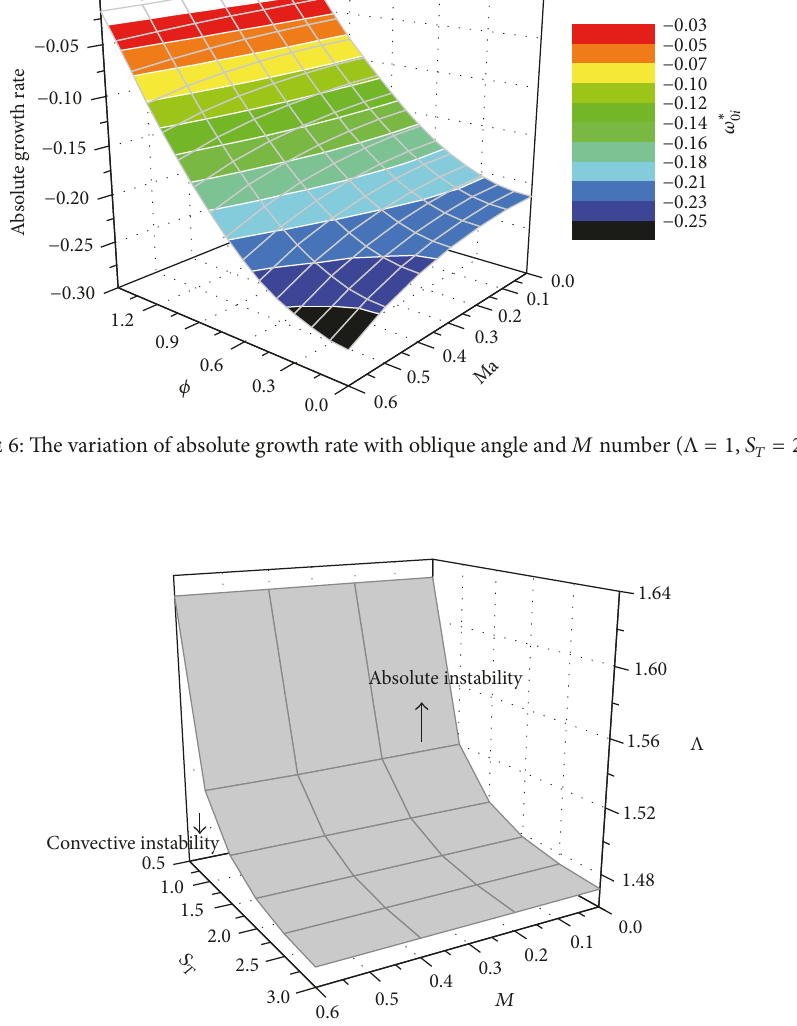
Figure 7: The boundary of transition between AI and CI in the parameter space of Λ , 𝑀 , and 𝑆 𝑇 ( 𝜙 = 0